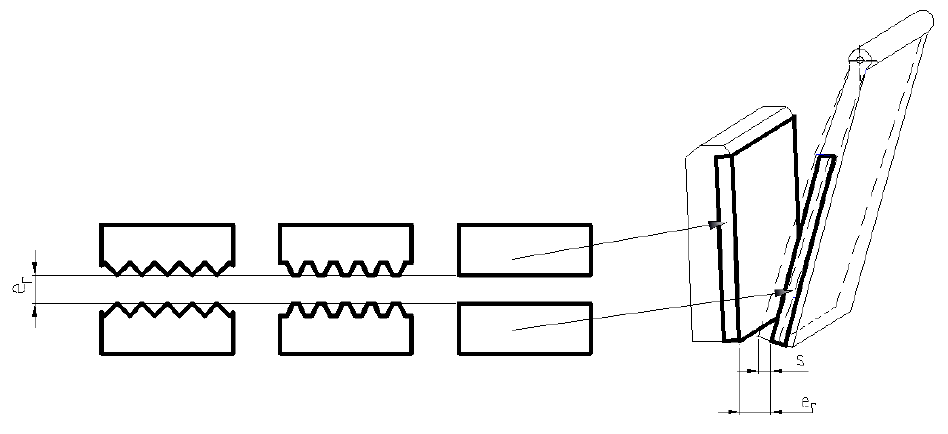
for different plate sets, s - moving jaw displacement (throw) r [%] n